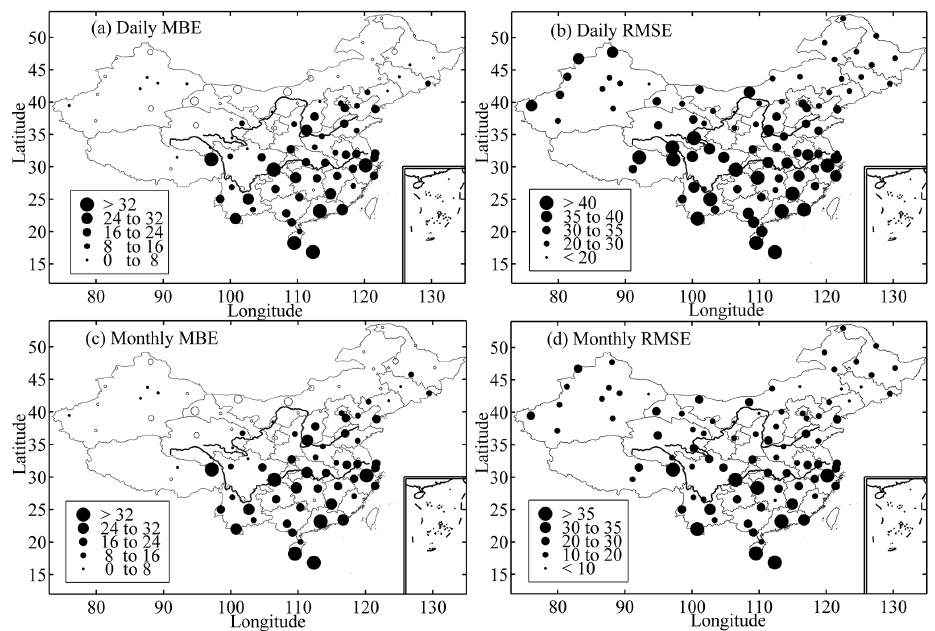
Figure 9. Spatial distributions of MBE and RMSE for daily ( a, b ) and monthly ( c, d ) SSR estimates at all CMA radiation stations in 2009. The size of the circles corresponds to the MBE and RMSE values. The solid circle means that the MBE is greater than zero, and the open circle means that the MBE is less than zero. The units of RMSE and MBE described on the legend are in Wm − 2 .